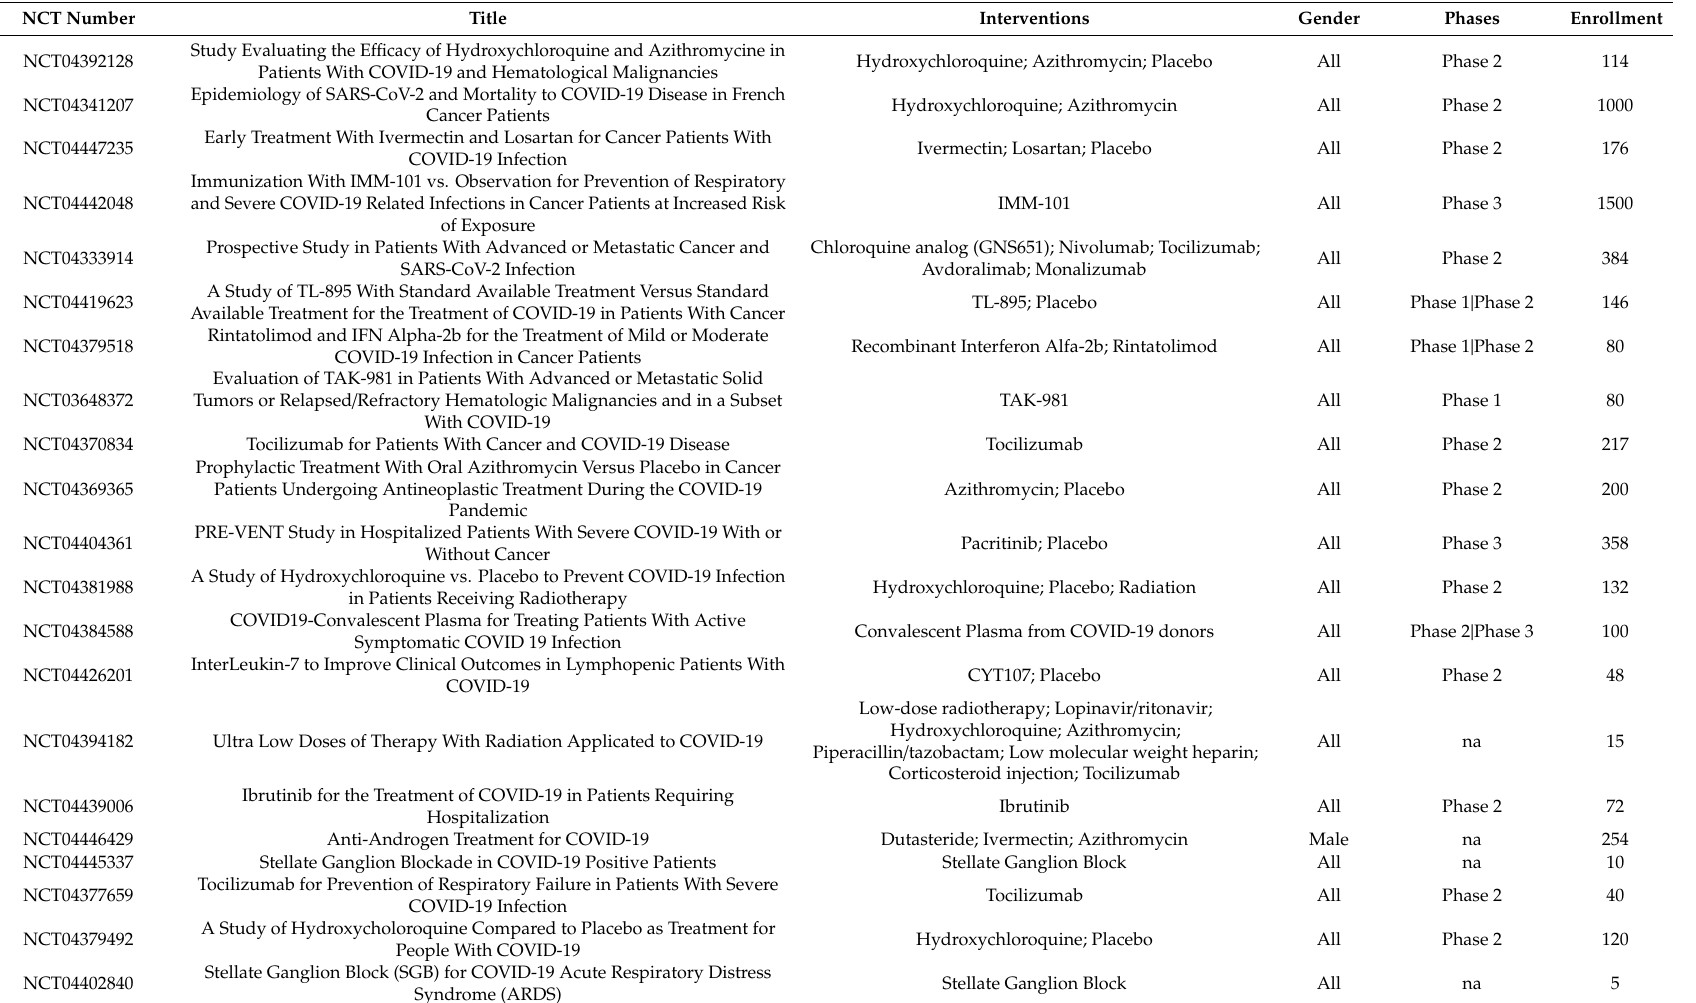
Table 1. Open clinical studies registered at clinicaltrials.gov on coronavirus disease 2019 (COVID-19) and